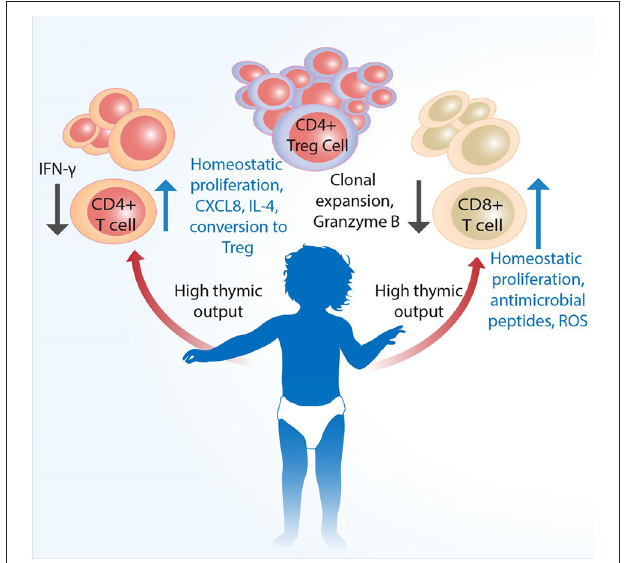
FIGURE 1 | Infant T cells are qualitatively distinct from adult cells. Conventional T cells develop in the thymus, the size as well as output of which is largest at birth. Mature single CD4 + and CD8 + cells are proportionally less than Tregs across various tissues. Although infants have substantial populations of fully developed single CD4 + and CD8 + cells T cells from birth, these are predominantly naïve and more prone to type 2 cytokine and innate-like responses following activation. Naïve CD4 + T cells have higher propensity to develop into FoxP3 + Tregs to actively promote self-tolerance. An increased susceptibility to infection in neonates is likely not a result of only immaturity of adaptive immunity, but also that of qualitatively different functional capacity and higher level of immunosuppression, which together may negatively impact the eradication of malignant cells. pediatric ALL patients are warranted. Recent data suggest that the